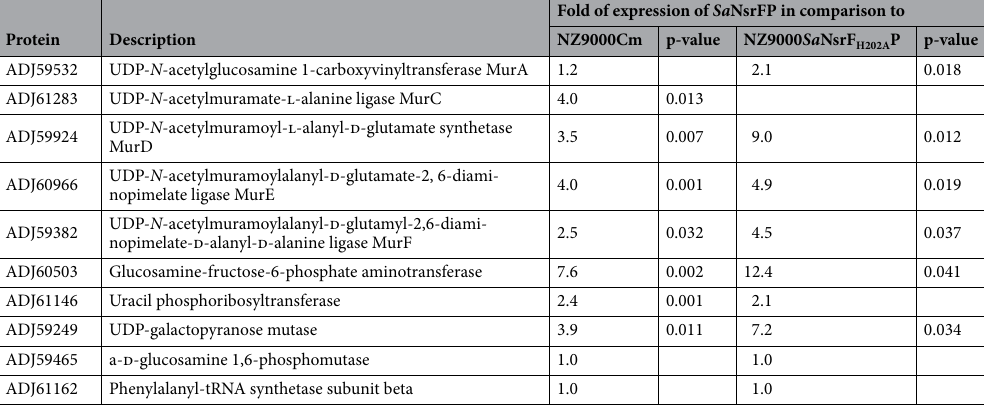
Table 2. Selected proteins of the proteome analysis with their description and their fold of down regulation in NZ9000 Sa NsrFP compared to NZ9000Cm and NZ9000 Sa NsrF H202A P. The number of replicates were n = 5. We performed an ANOVA test and the p values are also part of the protein lists. Only significant p-values were listed.